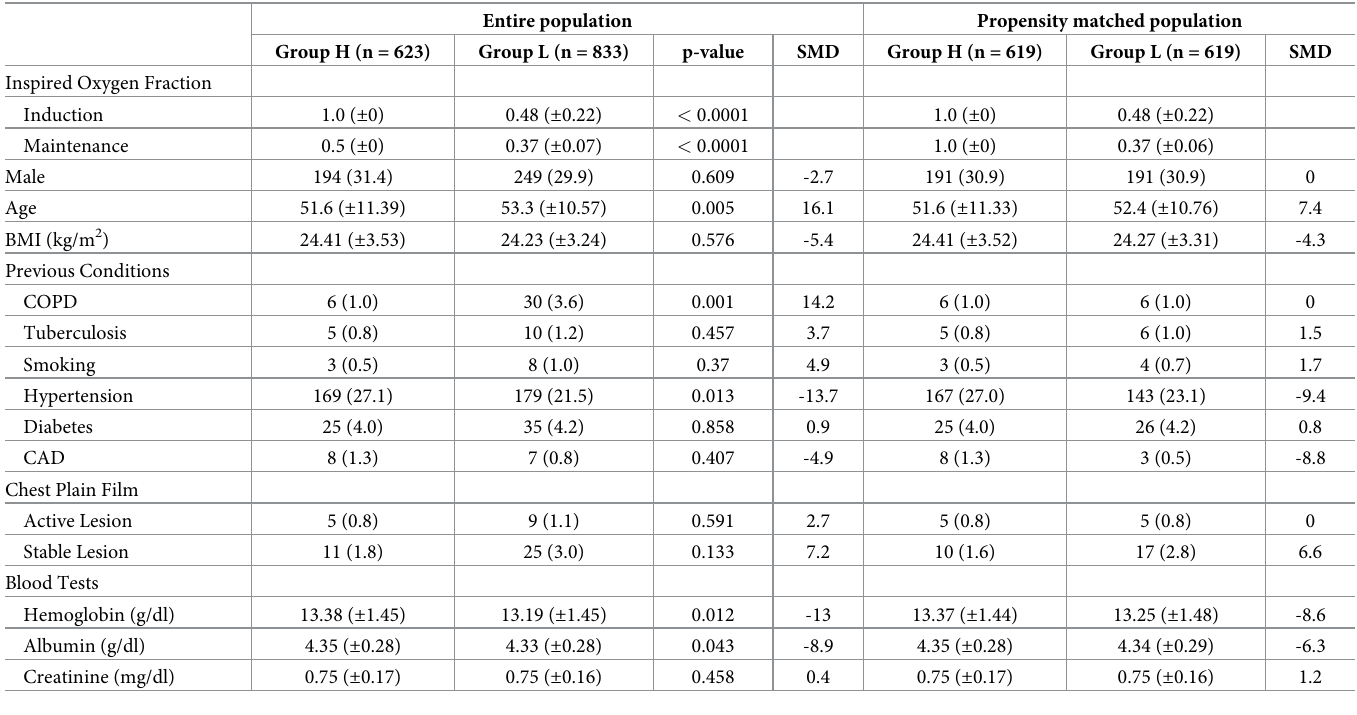
Table 1. Preoperative variables.